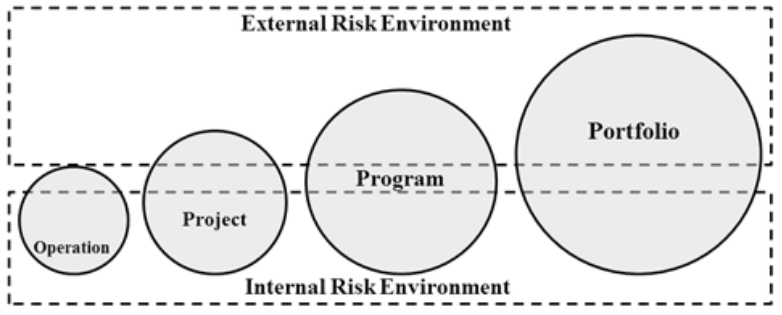
Figure 2. Endeavors with Varying Level of Risk